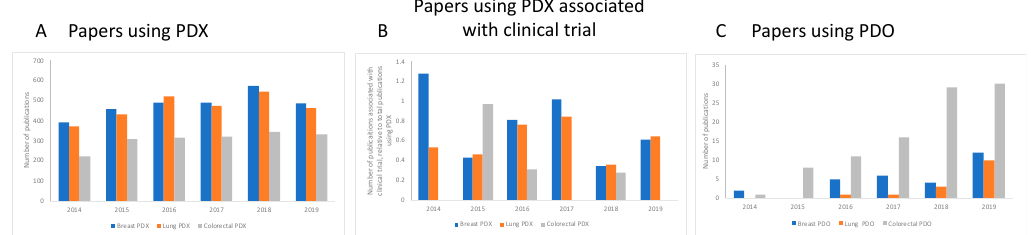
Figure 3. Year-on-year analysis of the number of papers published worldwide using PDX ( A ), the proportion of those papers that used PDX and were associated with clinical trials ( B ), and the number of papers published using PDO ( C ). The number of studies using PDX, for all three types of cancer, shows some fluctuations but overall remain the same over the time period evaluated ( A ). Likewise, there is no growing trend for the number of publications using PDX and associated with clinical trials between 2014 and 2019 ( B )—these data are expressed as the number of studies associated with a clinical trial relative to the total number of publications using PDX. However, panel C shows that the number of published studies using PDO increase over time but note that the total number of papers is still low compared to the number of studies using PDX (panel A).